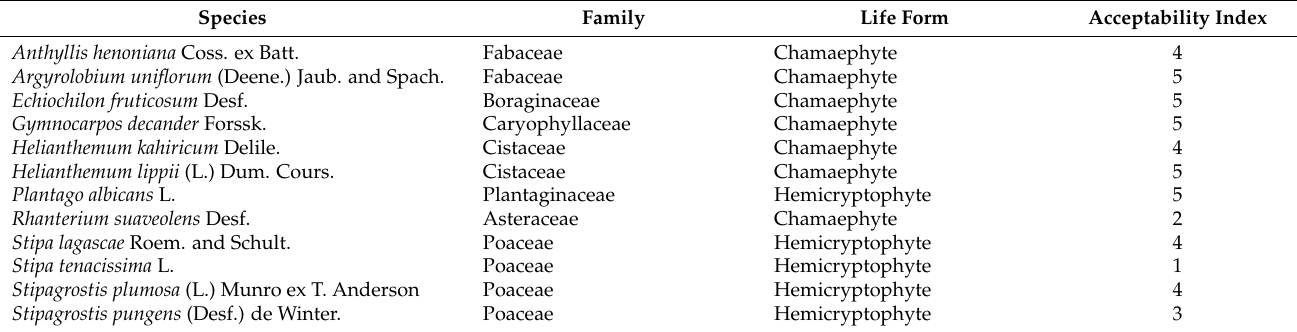
Table 2. Family, life form, and livestock acceptability index of studied species of southern Tunisia. 0: refusal or toxic; 1: occasionally palatable; 2: few palatable; 3: palatable; 4: very palatable; 5: extremely palatable.